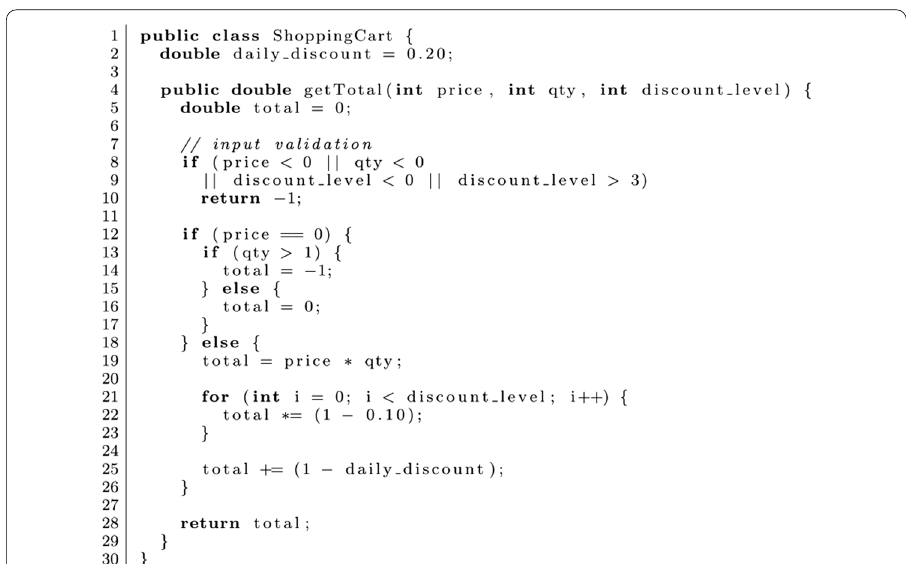
Fig. 4 Sample class ShoppingCart. A sample class having several execution paths